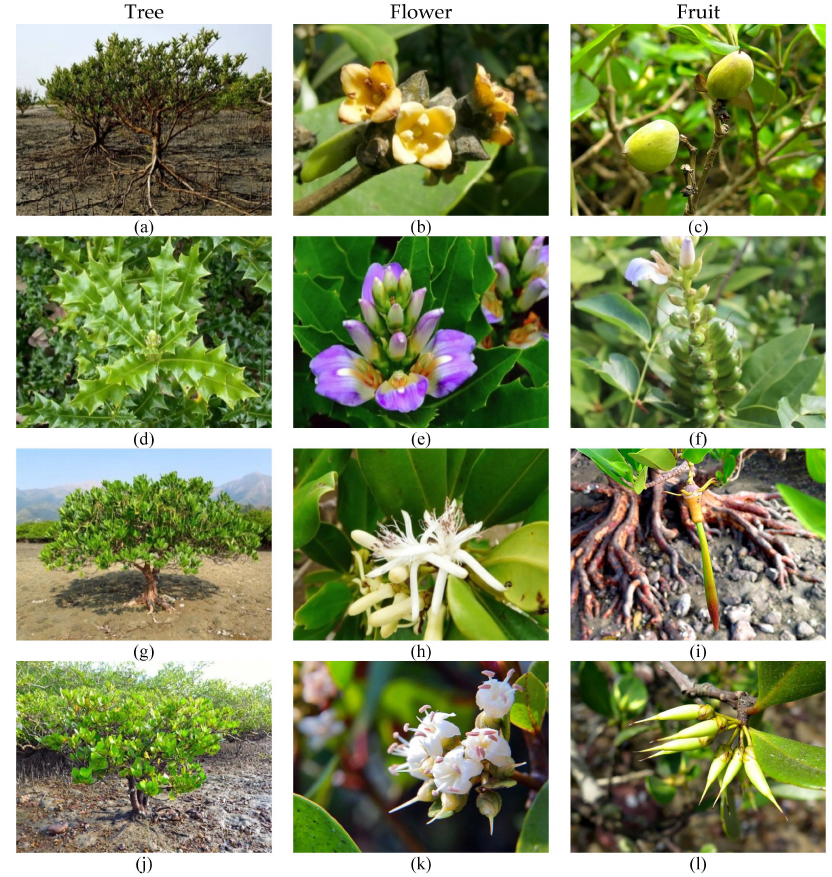
Figure 2. The four primary species of mangroves in Hong Kong during different phenological periods.